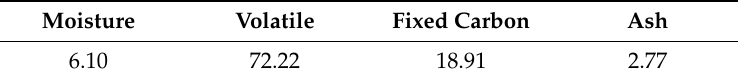
Table 1. Proximate analysis (wt%) of co ff ee ground (wet basis).